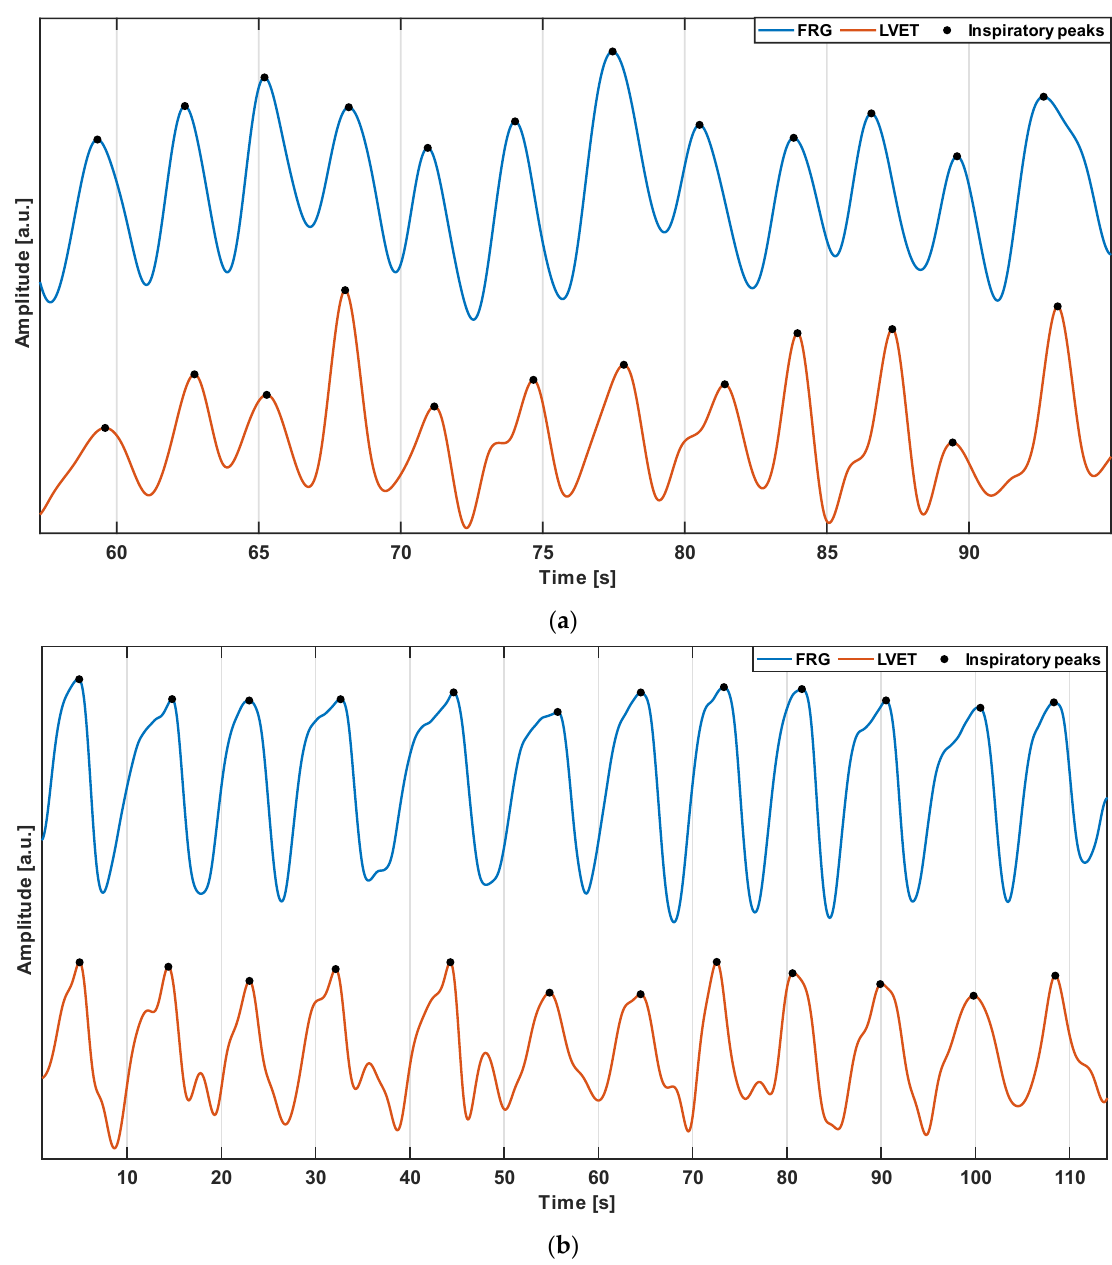
Figure 4. Excerpts of the FRG signal (blue line) and LVET trend (orange line) from: ( a ) subject #2; ( b ) subject #4.